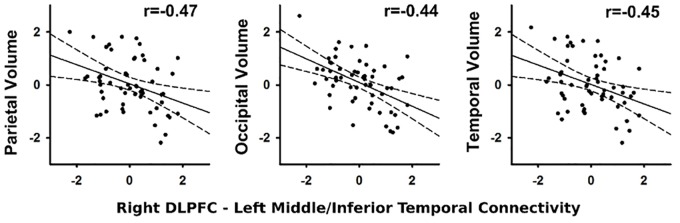
Association between abnormal context-dependent connectivity of the right DLPFC (BA 9) – left middle/inferior temporal gyrus and brain volumes. The x and y axes plot the standardized residuals (adjusted for sex) for context-dependent connectivity and brain volumes. Solid lines show the best-fitting linear regression line and dashed lines represent the 95% confidence intervals. Pearson correlation coefficients are displayed in the upper right corner of each scatter plot.